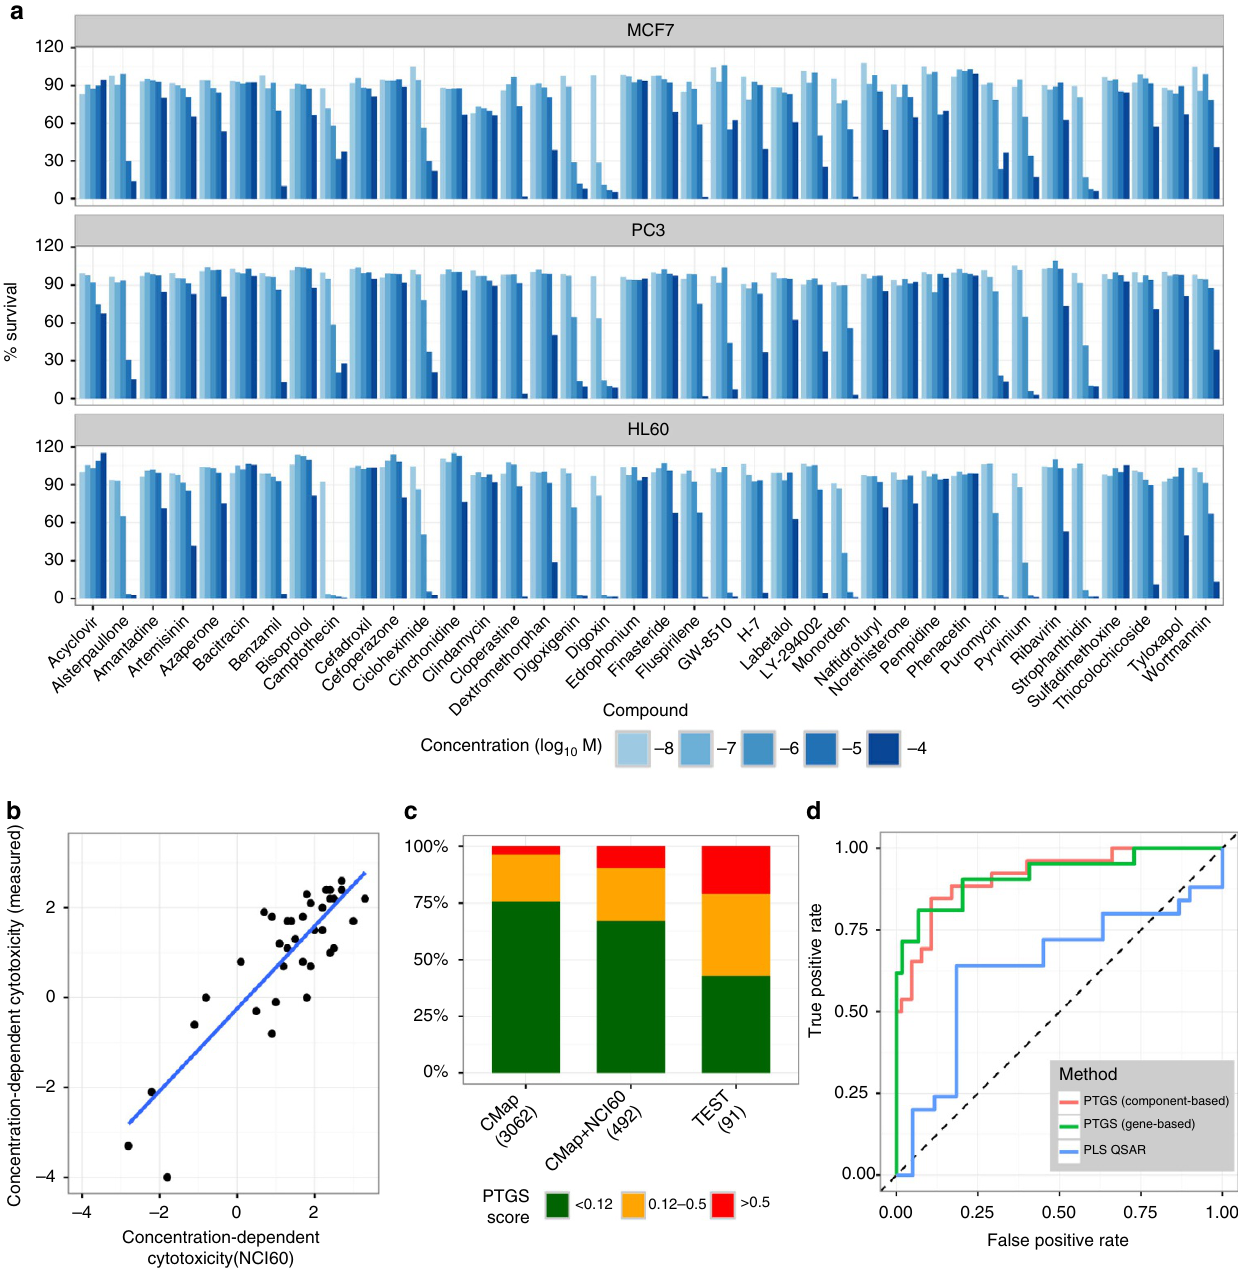
Figure 4 | High-throughput screening cell-based validation of PTGS to predict cytotoxicity in the CMap database. ( a ) Cell survival measured in the three CMap cell lines at different concentration levels for 38 non-NCI-60 CMap compounds. ( b ) Concentration-dependent cytotoxicity values of 16 compounds (36 instances) indicated data agreement between the NCI-60-based test and the chosen cytotoxicity assay (ATP content) (Pearson correlation 0.86). As shown, the classification of toxic versus non-toxic repeated in 32 of 36 instances, and the four instances where this changed had a score close to the cut-off in both data sets. ( c ) Proportions of CMap, CMap/NCI-60 crossover and validation (test) instances predicted by the PTGS to have been measured above the GI 50 -level show a balance of toxic and non-toxic treatments (numbers tested shown). About 25% of 3062 CMap profiles are predicted to be above the GI 50 levels. ( d ) ROC curves indicating the cytotoxicity-predictive performance of the gene-based, component-based and the Partial Least Squares QSAR methods. The AUC values were 0.92 ( n ¼ 80), 0.91 ( n ¼ 91) and 0.64 ( n ¼ 85), respectively. Further details of the QSAR analysis are in Supplementary Fig. 7. For screening data see Supplementary Data